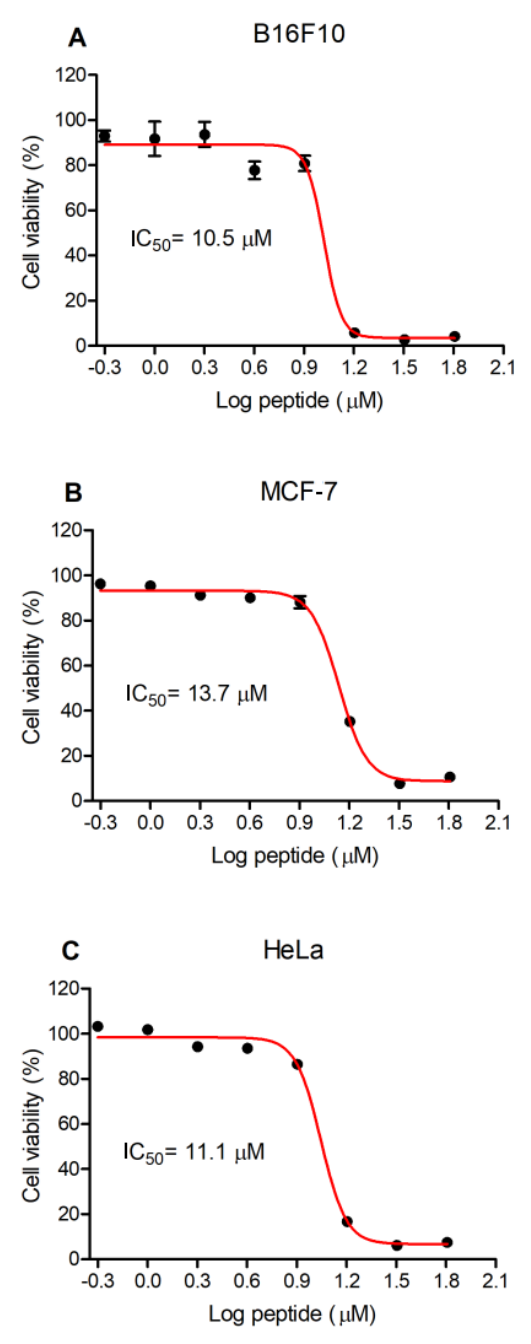
Figure 6. The effect of Figainin 1 on the proliferation of ( A ) murine skin melanoma B16F10 cells, ( B ) human mammary adenocarcinoma MCF-7 cells and ( C ) human cervical adenocarcinoma HeLa cells.